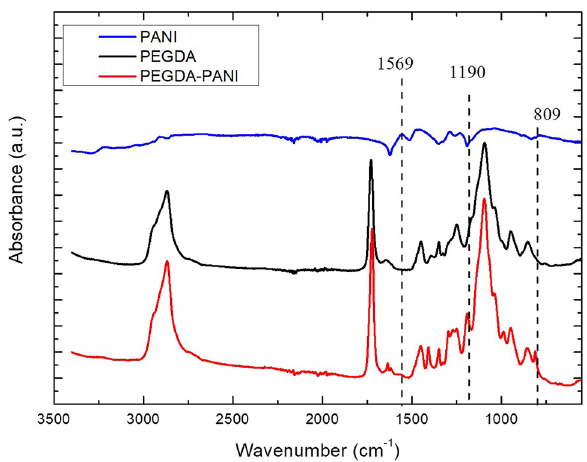
Figure 7. FTIR-ATR spectrum of conductive (emeraldine salt) form of PANI (blue), PANI embedded in PEGDA (red) and PEGDA (black).